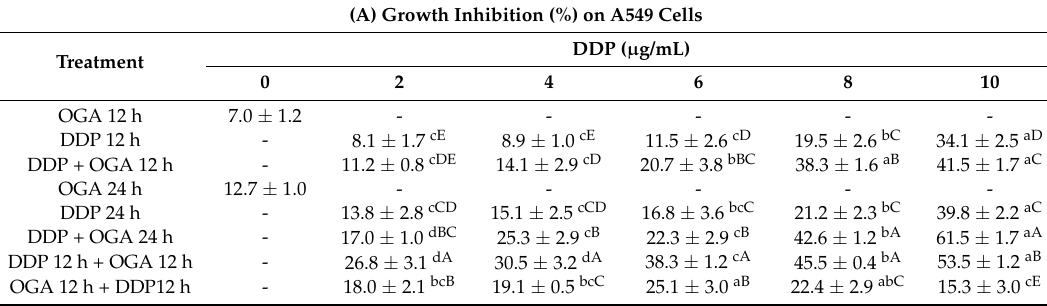
Table 1. Growth inhibition of cisplatin (DDP) and oligogalacturonides (OGA) on human lung cancer A549 cells and normal human embryonic kidney HEK293